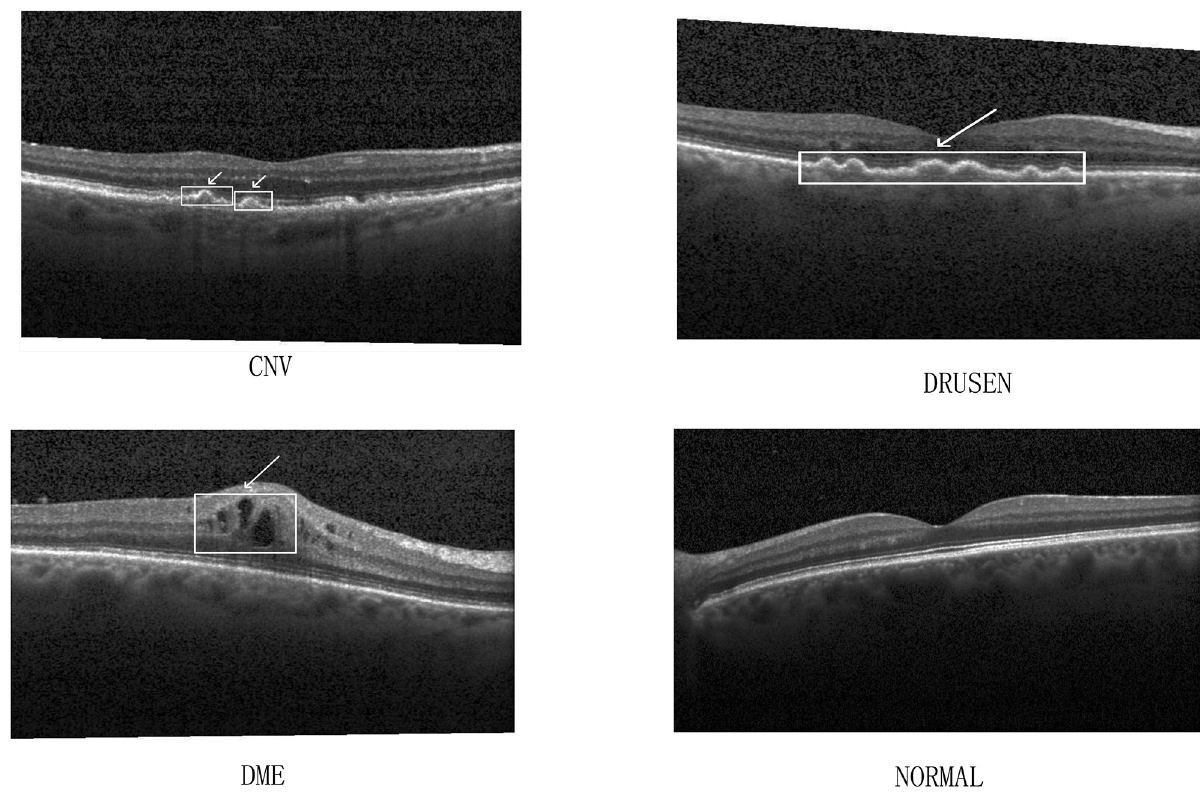
Fig 1. Sample demo of the